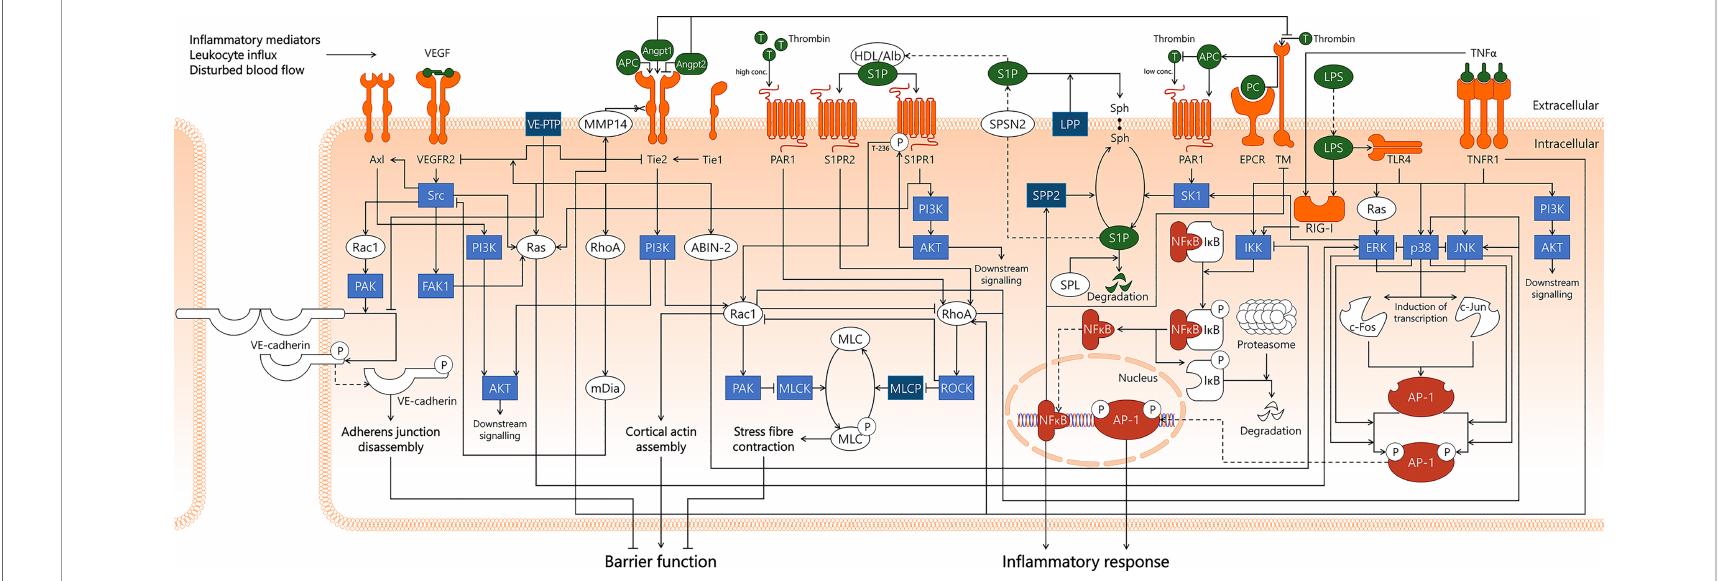
FIGURE 7 | Integration of signal transduction pathways involved in endothelial responses in sepsis that affect endothelial barrier function and in fl ammatory responses. From left to right, this fi gure displays the VEGF/ VEGFR2, Angpt/Tie2, Rac1/RhoA GTPases, APC/S1P, NF- k B, and AP-1 signal transduction pathways. This overview illustrates the complexity of the interactions of pathways involved in the endothelial response to sepsis, as well as displaying the numerous links that exist between different pathways. Coagulation-affecting pathways are not separately indicated for clarity reasons. ABIN-2, A20-binding inhibitor of NF- k B activation- 2; AKT, protein kinase B; Alb, albumin; Angpt1, angiopoietin-1; Angpt2, angiopoietin-2; APC, activated protein C; AP-1, activator protein 1; Axl, Axl receptor tyrosine kinase; c-Fos, cellular Fos proto-oncogene; c-Jun, cellular Jun proto-oncogene; EPCR, endothelial protein C receptor; ERK, extracellular signal-regulated kinase; FAK1, focal adhesion kinase 1; HDL, high-density lipoprotein; IKK, I k B kinase; I k B, inhibitor of k B; JNK, c- Jun N-terminal kinase; LPP, lipid phosphate phosphatase; LPS, lipopolysaccharide; mDia, mammalian Diaphanous-related formin Dia; MLC, myosin light chain; MLCK, myosin light chain kinase; MLCP, myosin light chain phosphatase; MMP14, matrix metalloproteinase-14; NF- k B, nuclear factor kappa-light-chain-enhancer of activated B cells; p38, p38 mitogen-activated protein kinase; PAK, p21-activated kinase; PAR1, protease- activated receptor 1; PC, protein C; PI3K, phosphoinositide 3-kinase; Rac1, Ras-related C3 botulinum toxin substrate 1; Ras, Ras protein subfamily; RhoA, Ras homolog gene family, member A; RIG-I, retinoic acid- inducible gene I; ROCK, Rho-associated protein kinase; S1P, sphingosine-1-phosphate; S1PR1, sphingosine-1-phosphate receptor 1; S1PR2, sphingosine-1-phosphate receptor 2; SK1, sphingosine kinase 1; Sph, sphingosine; SPL, sphingosine-1-phosphate lyase; SPNS2, Spinster homolog 2; SPP2, sphingosine-1-phosphate phosphatase 2; Src, Src protein tyrosine kinase; T, thrombin; Tie1, tunica intima endothelial kinase 1; Tie2, tunica intima endothelial kinase 2; TLR4, Toll-like receptor 4; TM, thrombomodulin; TNFR1, tumor necrosis factor alpha receptor 1; TNF a , tumor necrosis factor alpha; VEGF, vascular endothelial growth factor; VEGFR2, vascular endothelial growth factor receptor 2; VE-cadherin, vascular endothelial cadherin; VE-PTP, vascular endothelial protein tyrosine